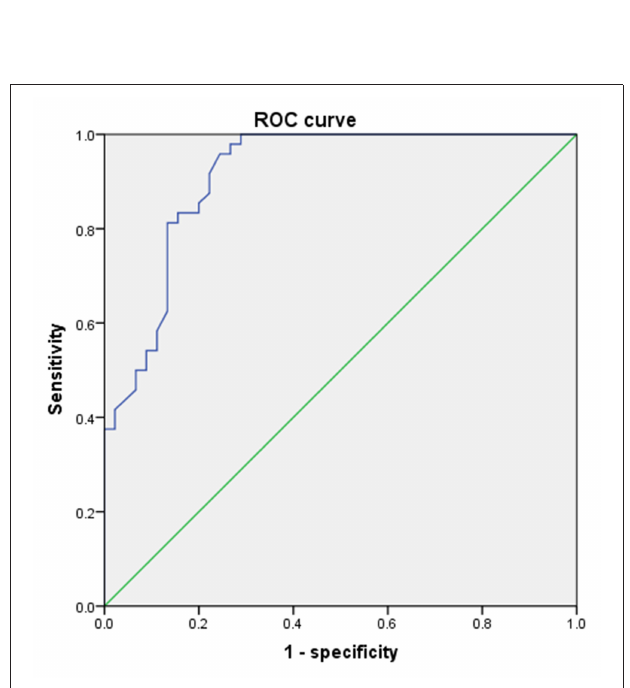
FIGURE 5 | The ROC curve of uric acid to predict puberty in females.